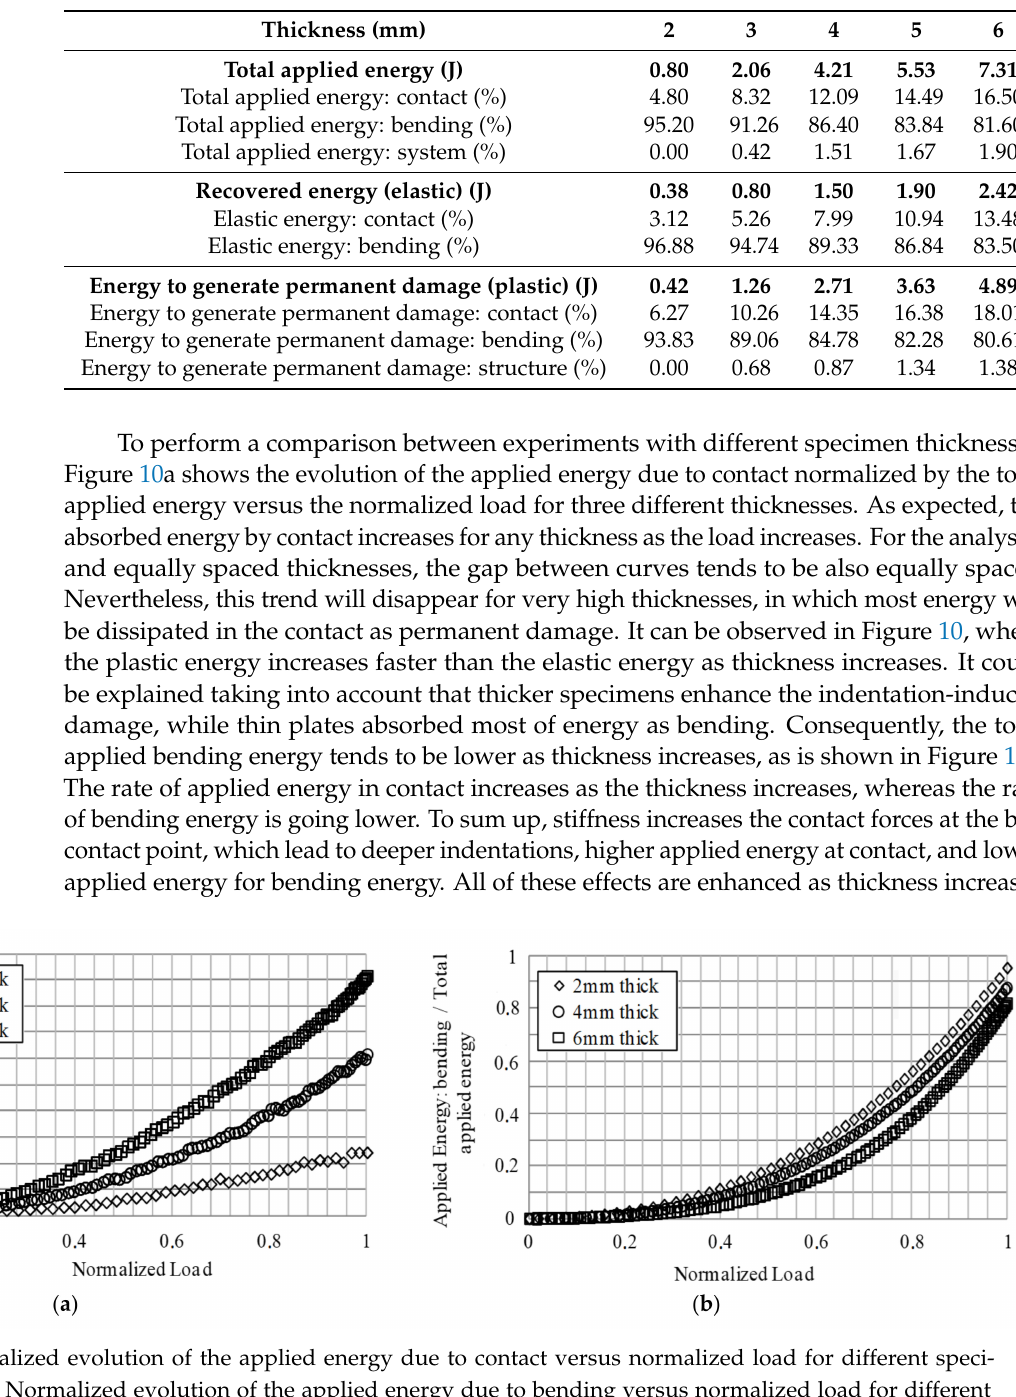
Table 3. Energy balance for contact experiments with different specimen thicknesses.